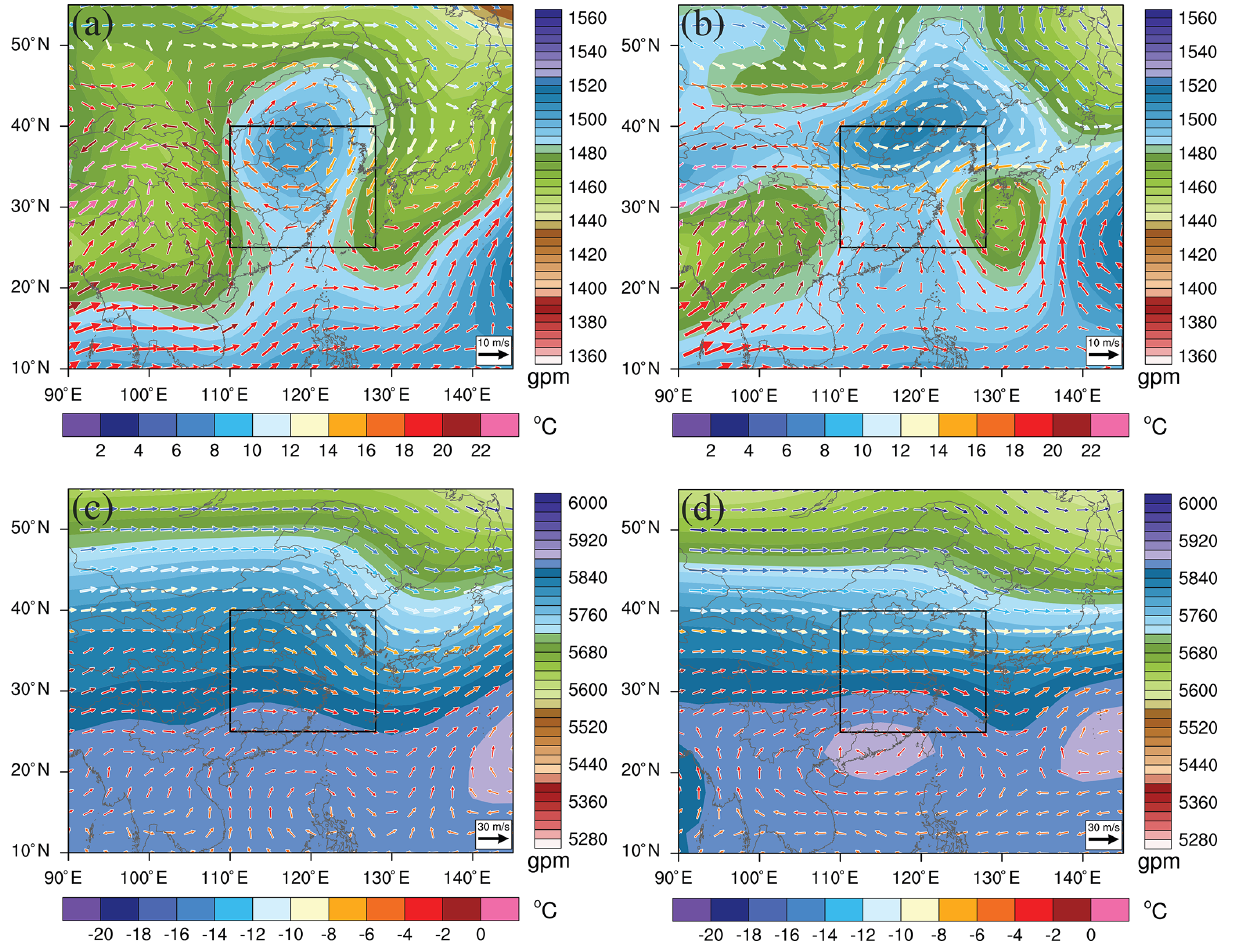
Figure 8. The geopotential height (shaded) and 850hPa wind with temperature (color vector) under (a) SWP5_Pos and (b) SWP5_Neg. The geopotential height (shaded) and 500hPa wind with temperature (color vector) under (c) SWP5_Pos and (d) SWP5_Neg. The boxed area in panels (a) – (d) encloses the